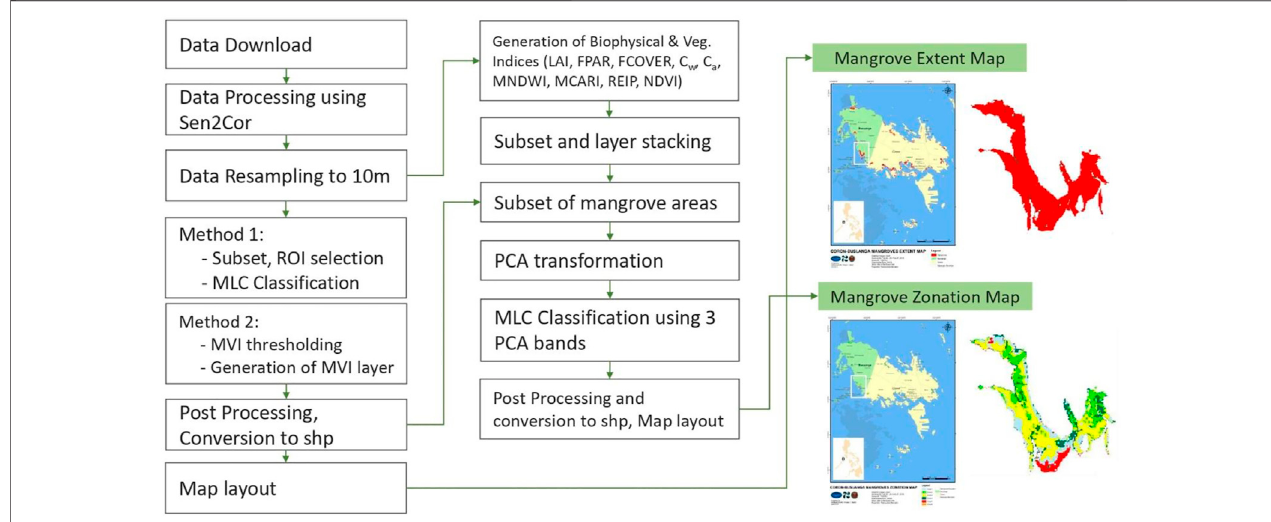
FIGURE2| Overviewofthemethodologyusedingeneratingmangroveextentandzonationmaps.Therearetwomethodsforgenerationtheextentmap,oneisby MLC and another by the use of MVI. The products of extent mapping will be used as boundary to the zonation mapping, wherein vegetation, water, and biophysical products will be inputted as source products.